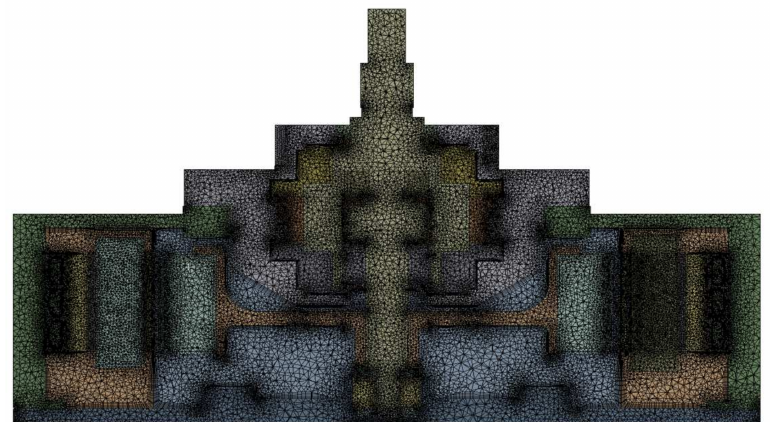
Figure 5. Grid model of whole configuration.